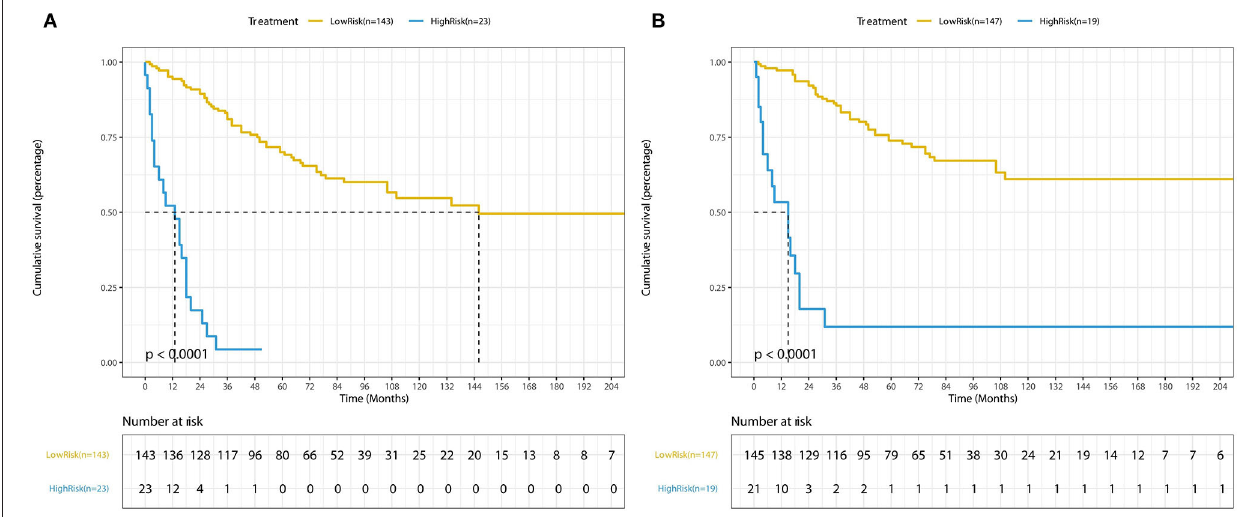
FIGURE 4 | Kaplan-Meier curves of low-risk and high-risk based on the predictions of the nomograms (A) for OS and (B) for CSS.